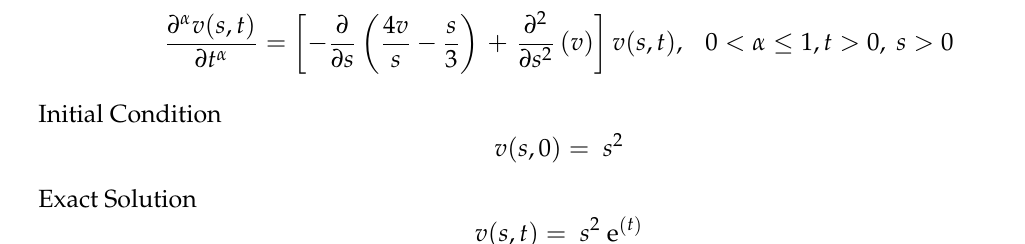
Figure 5:2D Solutions of example1 for Figure 5. 2D Solutions of Example 1 for different values of α di⁄erent values of (cid:11)